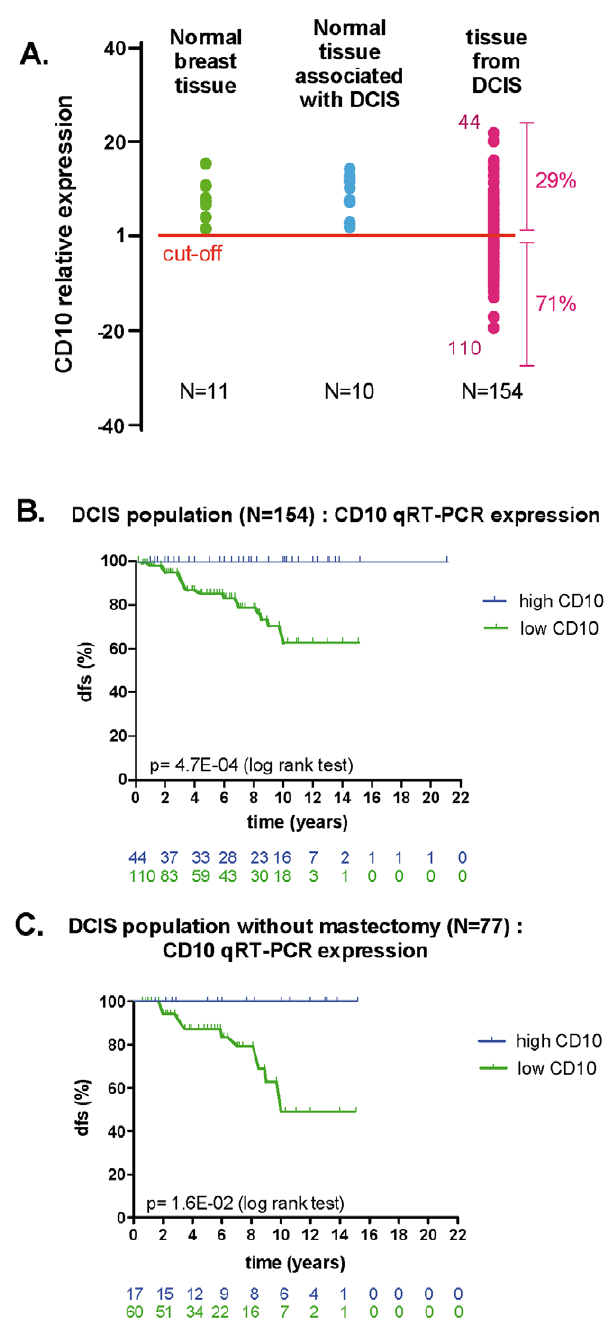
Figure 2. CD10 expression and clinical outcome. (A) scatter plot of CD10 expression evaluated by qRT-PCR for normal (N=11) and DCIS (N=154) samples. All normal samples and one-third of the DCIS were considered CD10 positive. (B) Kaplan-Meier curves of disease-free survival for patients with DCIS (N=154) according to CD10 mRNA expression by qRT-PCR expression. (C) Kaplan-Meier curves of disease- free survival for patients with DCIS treated by tumorectomy only or tumorectomy and radiation (N =77) according to CD10 mRNA expression by qRT-PCR expression. doi:10.1371/journal.pone.0012100.g002 group of patients treated with lumpectomy, lumpectomy plus radiotherapy and mastectomy, respectively. In the groups of patients treated by lumpectomy or lumpectomy plus radiotherapy, none of the patients with high CD10 mRNA (N =17/77)